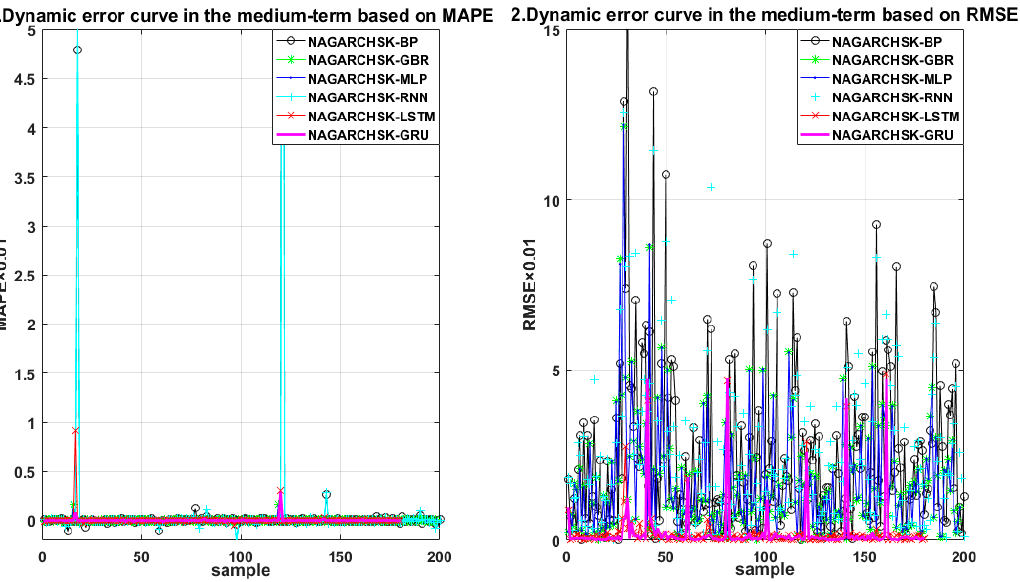
Figure 9. Error scatter distribution of the proposed and benchmark forecasting models considering the feature of time-varying, high-order moment in the short term. 5. Conclusions and Prospects 5.1. Conclusions As a market-oriented mechanism for innovation to curb global climate issues, the carbon market is recognized as the most effective means to reducing the global carbon dioxide emissions and realize the sustainability of human society and economic growth. Compared with other financial markets, the carbon market has obvious market asym- metry, is sensitive to policy shocks and has time-varying volatility. However, the existing carbon price-forecasting research mainly focuses on the price information transmission and risk volatility spillover from the perspective of low-order moment of return, and ig- nores the time-varying impact of asymmetric information and extreme policies on carbon assets from the perspective of high-order moment attributes (market skewness and kur- tosis). The explanation for carbon premium lacks sufficient evidential support.